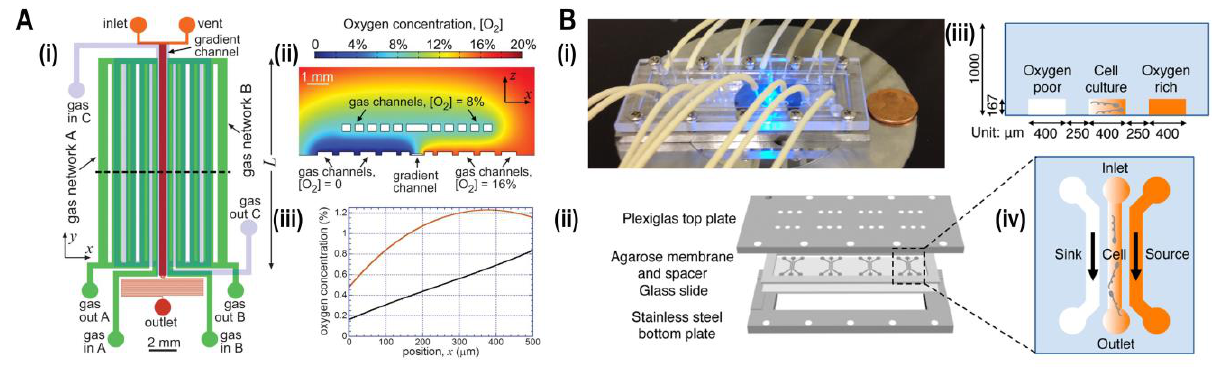
FIGURE 5: Microfluidic devices for bacterial aerotaxis. (A) Two-layered PDMS chip for generating oxygen gradients. (i) Lower layer supplied with gases by an in-plane gas channel network (A and B) and the top layer with gases by an out of plane gas channel network. (ii) Oxygen- diffusion simulation demonstrated that the oxygen gradient was generated ranging from 0 - 20% inside the chip. (iii) Simulation plot of oxy- gen concentration versus position 'x,' i.e., cross-section view of the gradient inside the channel. Incorporation of gas channel C in the device generates near-linear stable oxygen gradient (black line) in comparison with the condition of no gas channel C (Red curve). Reproduced from [44]. (B) Agarose-based chemical or oxygen gradient generator. (i) A microfluidic device on the microscopic stage with tubing to inject me- dia, containing oxidized flavin (chemo effector) or oxygen. (ii) Four three-channel microstructures were engraved in agarose membrane which was clamped by plexiglass plate at the top and stainless-steel plate at the bottom which was spaced by a glass slide. (iii) Schematic diagram of a single three-channel microstructure, consisting of the middle channel for the bacterial culture which was flanked by side chan- nels for either oxygen or oxidized flavin to generate a gradient across the middle channel. (iv) Side view of the channels with 250 μm spacing where oxygen-rich channel (coloured) and oxygen-poor channel (colourless) were juxtaposed to the middle channel containing an oxygen gradient. Reproduced from